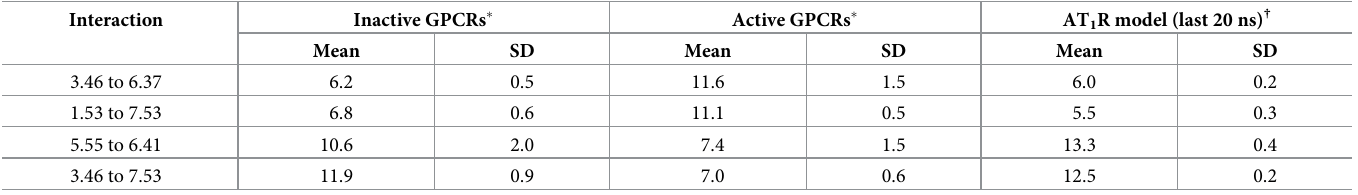
Table 1. Comparison of the apo-AT 1 R model structure to consensus changes in GPCR structure when activated and the AT 1 R crystal structures. All measurements are from the center of mass and are presented in angstroms.